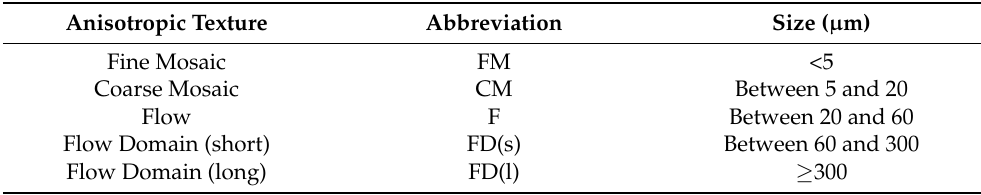
Table 1. Nomenclature of microstructure types of optical texture.